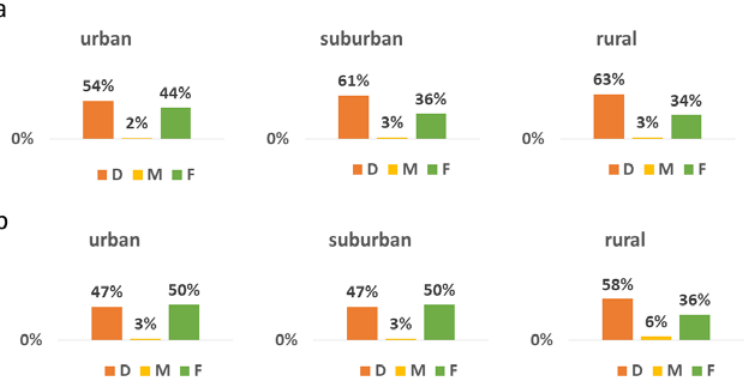
Figure 2. The distribution of DMFT according to the area in ( a ) 12-year-olds and ( b ) 15-year-olds in Serbia. Gingival bleeding was present in 26% of examined 12-year-old and 18% of 15-year- old children. Dental plaque was observed in 63% of both 12-year-olds (PI = 0.71±0.78) and 15-year-olds (PI = 0.61 ± 0.72) (Table 5).